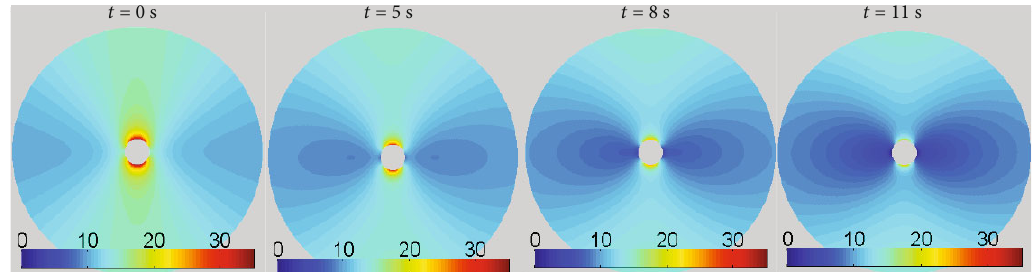
Figure 4: Wellbore breakdown process for the case of wellbore fl uid fl owing into rock but no seepage force.